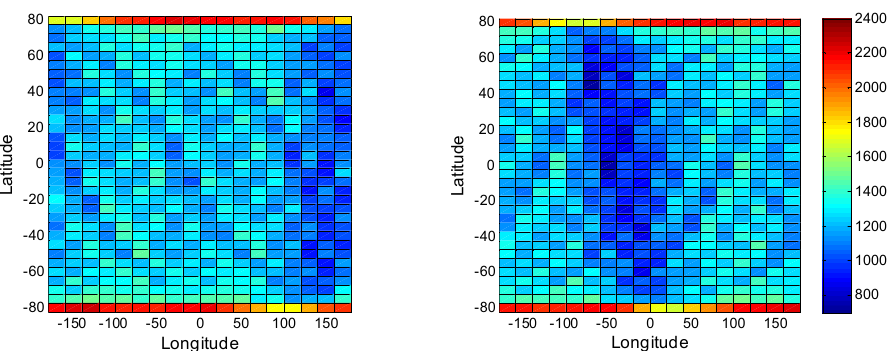
Figure 1. Global distributions of the samplings from APOD at dawn ( left ) and dusk ( right ) in July. The monthly averaged APOD density ( ρ ) is calculated in each grid at dawn or dusk, respectively. Then Equation (1) is used to obtain the zonal mean of the monthly averaged thermospheric density ( ρ ),